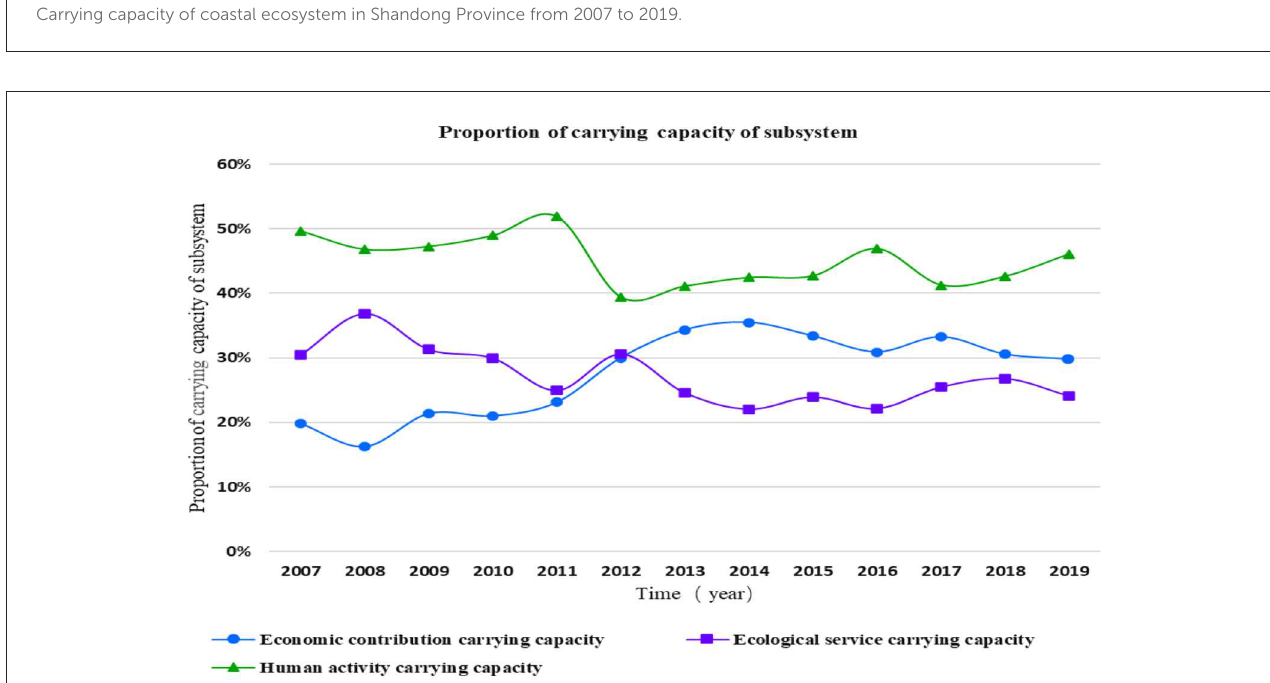
FIGURE11 Carrying capacity of coastal ecosystem subsystem in Shandong Province from 2007 to